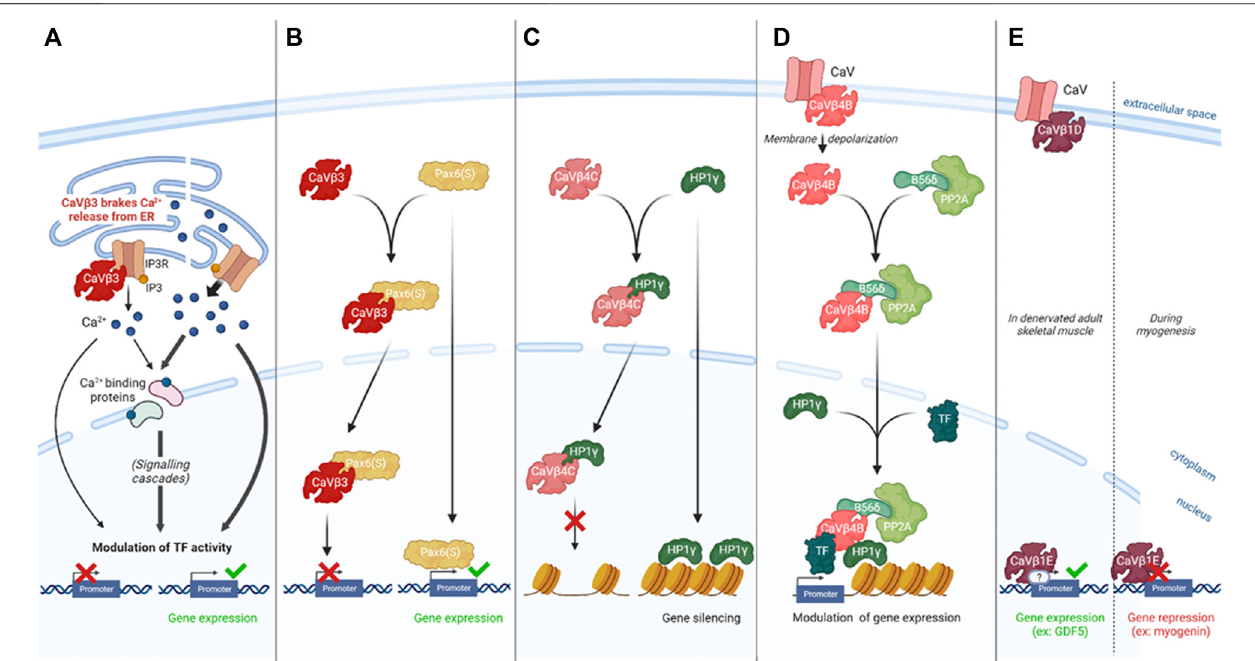
FIGURE1| CaV-independentCaV β sfunctionsinregulatinggeneexpression. (A) .CaV β 3interactswithIP3RtodesensitizecellstolowIP3concentrationandbrake Ca2+ release, consequently interfering with the Ca 2+ -related modulation of gene expression and affecting glucose-triggered insulin secretion in β -pancreatic cells (Becker, et al 2021) and fi broblasts mobility (Belkacemi et al., 2018). (B) . CaV β 3 translocates to the nucleus with Pax6(S), preventing its transcriptional activity (demonstrated in a reporter assay in vitro in HEK 293T cells) (Zhang et al. 2010). (C) . CaV β 4C translocates to the nucleus with HP1 γ , a factor known to silence the transcriptionofseveralgenesbymodulatingheterochromatinconformation.CaV β 4CinteractionwithHP1 γ preventsitsgenesilencingactivityinmammaliancells(Hibino et al. 2003, Xu et al. 2011). (D) . CaV β 4B acts as an organizing platform for transcription-modulating factors including PP2A, HP1 γ and the transcription factor TR α . CaV β 4B stabilizes this protein complex, allowing its modulatory activity on gene expression in hippocampal neurons in culture (Tadmouri et al. 2012). (E) . CaV β 1E acts directlyornotonDNAregulatorysequencestomodulategeneexpressionandin fl uencemyogenesisorskeletalmusclemasshomeostasisafterdenervation(Tayloretal. 2014, Traoré et al. 2019).